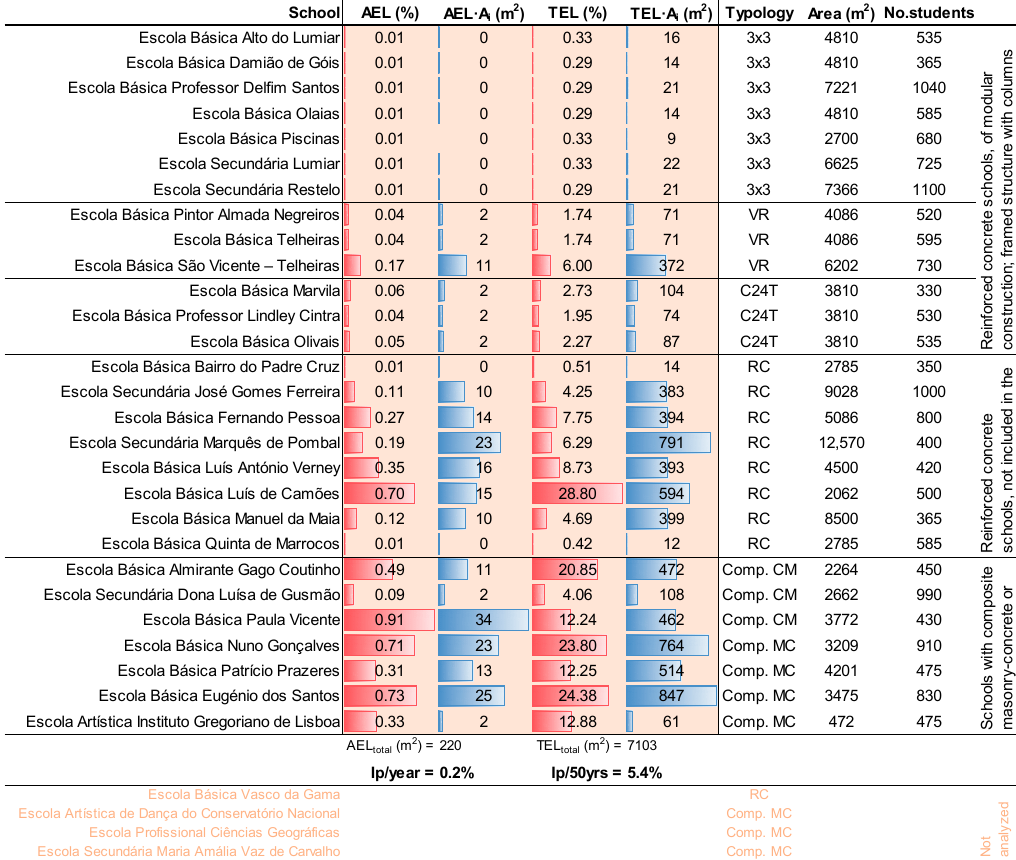
Figure 11. Expected losses as a function of the built area of the schools.